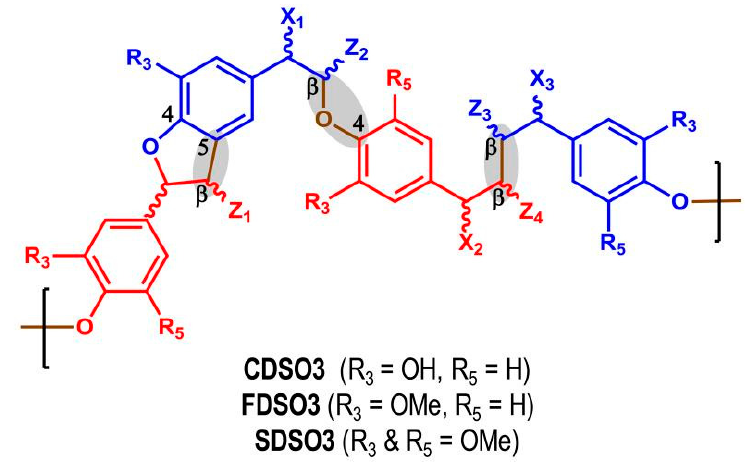
Figure 5. Sulfated low molecular weight lignins are complex three-dimensional oligomers obtained from enzymatic condensation of 4-hydroxycinnamic acid monomers using horseradish peroxidase followed by chemical sulfation using sulfur trioxide. The oligomers primarily contain β - O -4, β -5 and β – β inter-residue linkages (shown shaded). (Reprinted with permission from [43]).